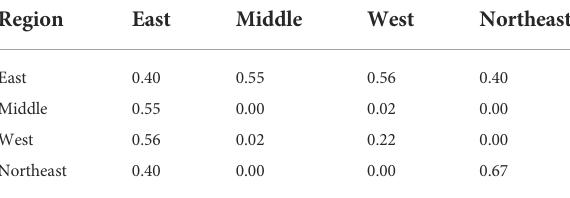
TABLE 3 Spatial correlation density matrix of ALTFP in four major regions of China in 2020.